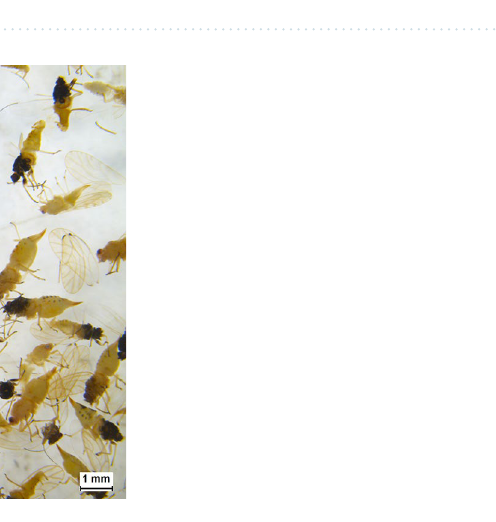
Figure 4. The Diuraphis noxia (Russian wheat aphid) nymph specimen responsible for the apparent “false positive” reads detected in the 1000 Pool 1 mock community, following non-destructive DNA